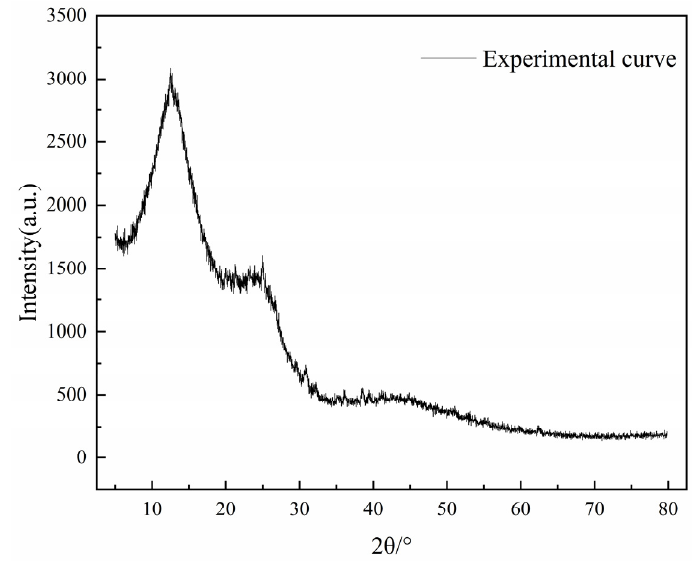
Figure 7. XRD spectrum of Kerjian coal. Table 12. Curve-fitted XRD of Kerjian coal.